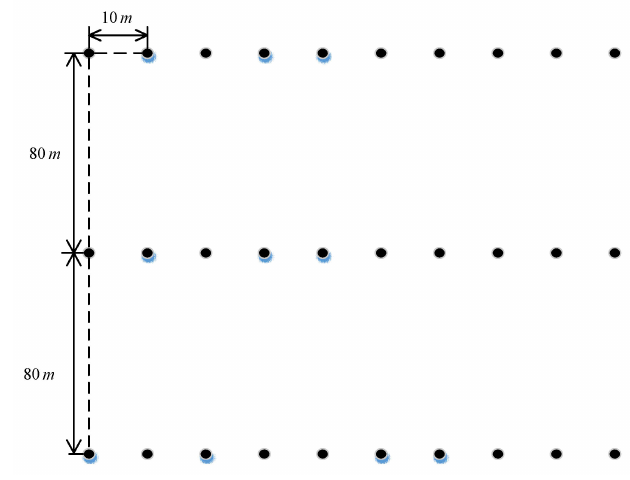
Figure 6. Geometric distribution of point targets.